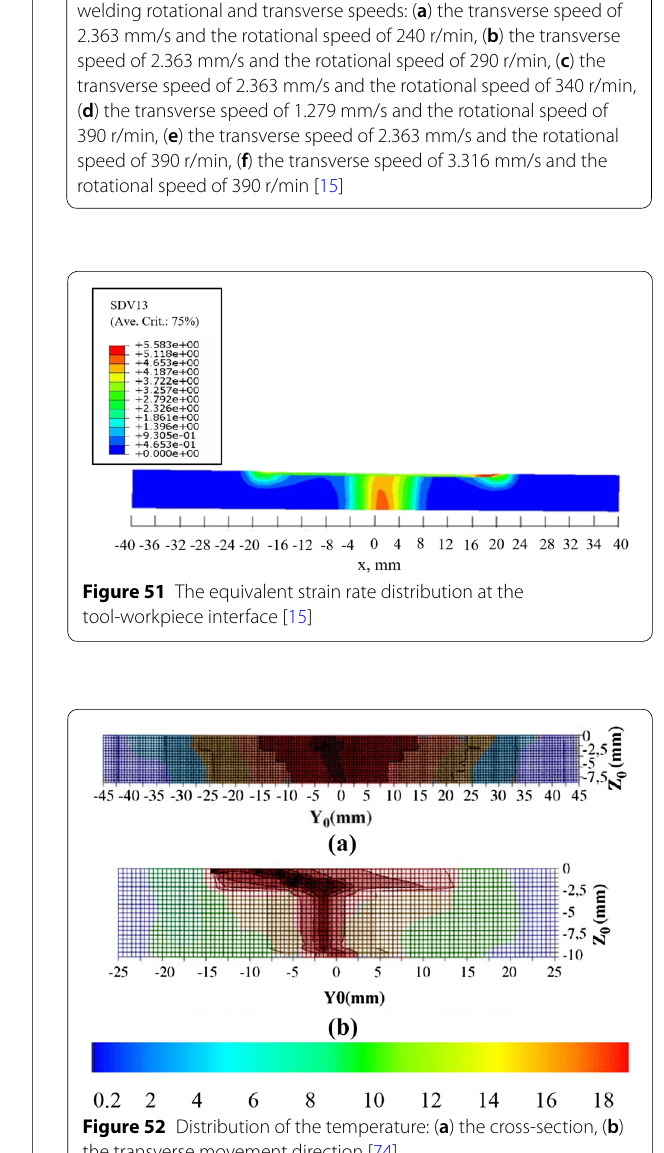
Figure 50 Contour plot of the equivalent plastic strain at different welding rotational and transverse speeds: ( a ) the transverse speed of 2.363 mm/s and the rotational speed of 240 r/min, ( b ) the transverse speed of 2.363 mm/s and the rotational speed of 290 r/min, ( c ) the transverse speed of 2.363 mm/s and the rotational speed of 340 r/min, ( d ) the transverse speed of 1.279 mm/s and the rotational speed of 390 r/min, ( e ) the transverse speed of 2.363 mm/s and the rotational speed of 390 r/min, ( f ) the transverse speed of 3.316 mm/s and the rotational speed of 390 r/min [15]